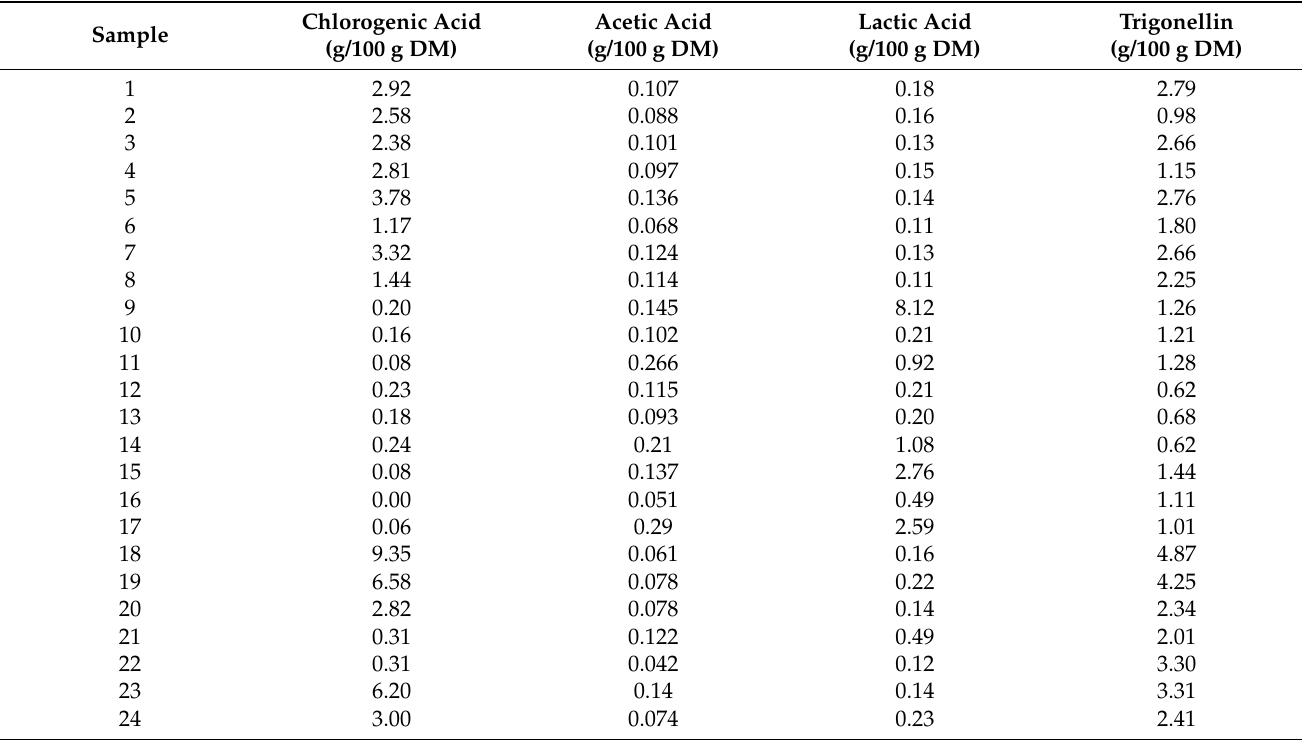
Table A4. Results of the NMR analysis of the organic acid contents.